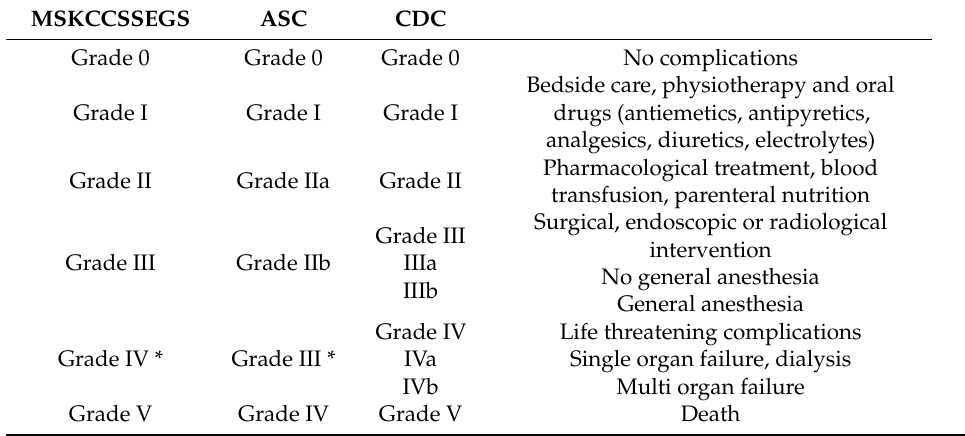
Table 1. Grading systems for post-operative